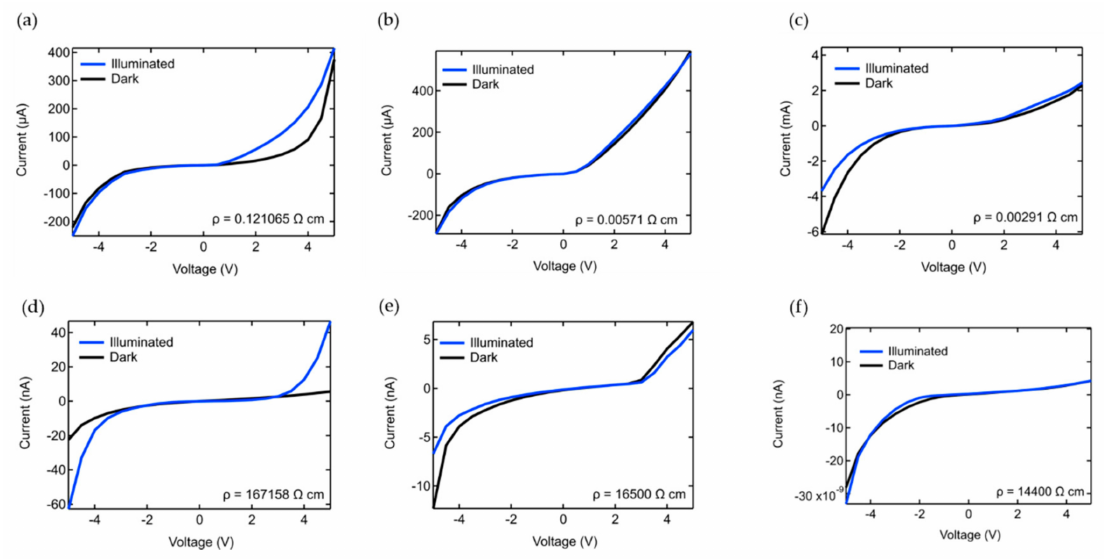
Figure 9. IV curves of ( a – c ) thin films of GaN, AlN / GaN, and Al 2 O 3 / AlN / GaN and ( d – f ) NS coated with GaN, AlN / GaN, and Al 2 O 3 / AlN / GaN, respectively. Measurements were taken with 470 nm light (blue) and dark (black) conditions. Resistivity measurements under dark conditions have for each sample have been